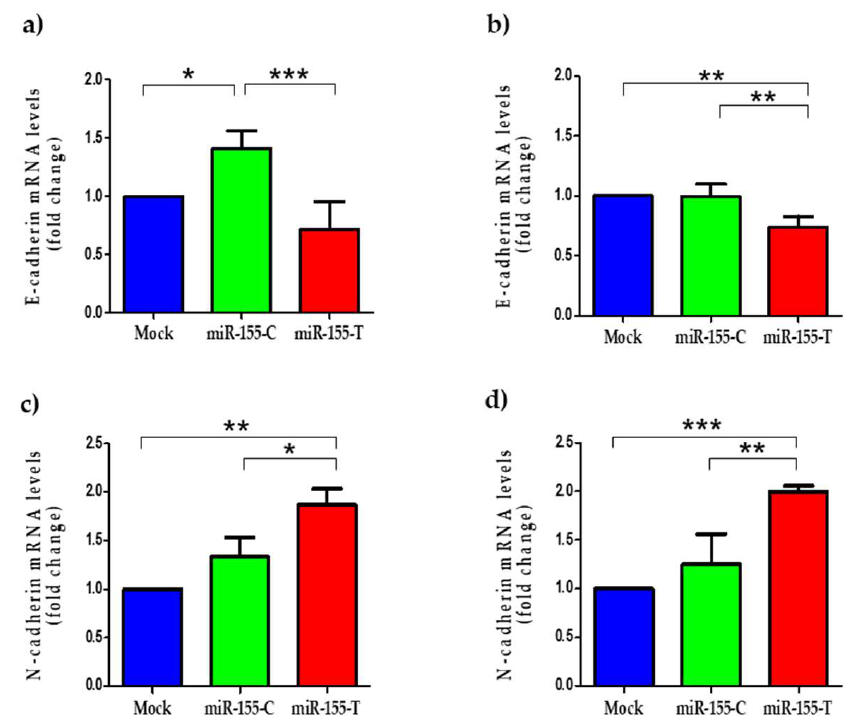
Figure 5. Effect of the miR-155-T allele on mRNA levels of EMT-related genes. BC cell lines were transfected with miR-155-C, miR-155-T, or mock vectors as indicated and grown for 24 h in complete media. The graphs show the relative E-cadherin mRNA levels in MDA-MB-231 ( a ) and MCF-7 ( b ) cell lines. Relative N-cadherin mRNA levels in MDA-MB-231 ( c ) and MCF-7 ( d ) cell lines. The level of GAPDH mRNA was used as a reference. The plotted values indicate the average of three independent experiments ± SD. * p < 0.05; ** p < 0.01; *** p < 0.001.